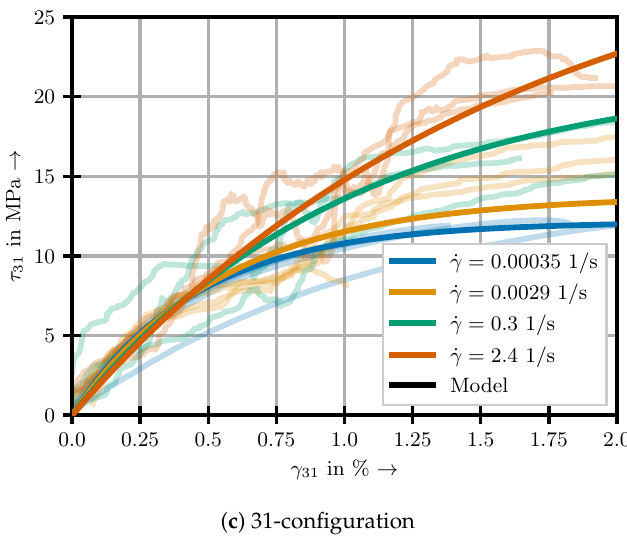
Figure 10. Comparison of experimental results and presented model.